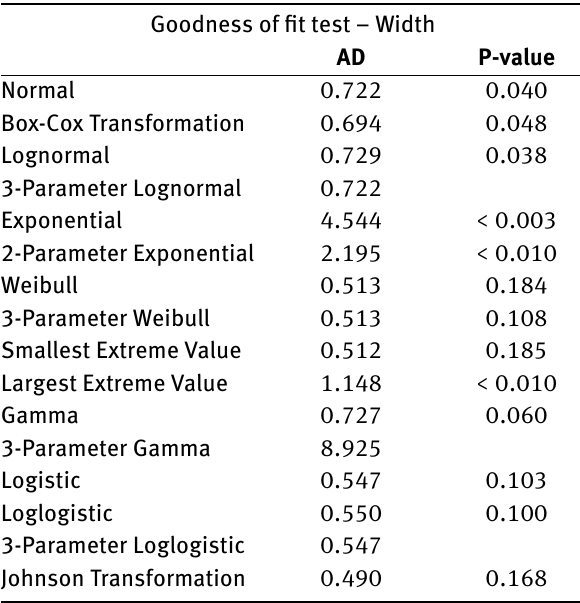
Table 5: Individual distribution identification for the thickness of